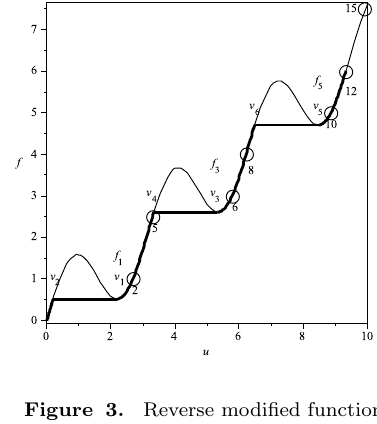
Figure 3. Reverse modified function f ( u ) at Bm = 1 . 5. The following numerical values are shown in figure: v 1 = 2 . 1863, v 2 = 0 . 1968, v 3 = 5 . 3279, v 4 = 3 . 3384, v 5 = 8 . 4695, v 6 = 6 . 4800, f 1 = 0 . 5147, f 3 = 2 . 6091, f 5 = 4 . 7035 . In the fixed points (cid:74) there are values of ωτ with the coordinates ( β s (1) ,ωτ/ 2)